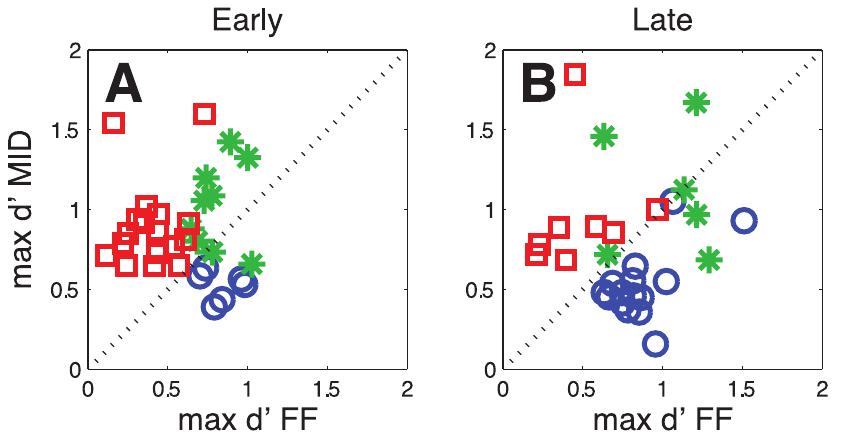
Figure 5. Strength of extraclassical responses. Comparison of the maxima of the remapping responses to MID and FF probes shown separately for early (A) and late (B) extraclassical responses across the two monkeys. Neurons showing significant extraclassical responses only to the MID- probes are marked as red squares, those showing only remapping of the FF-probes as blue circles and those for both probes as green stars.